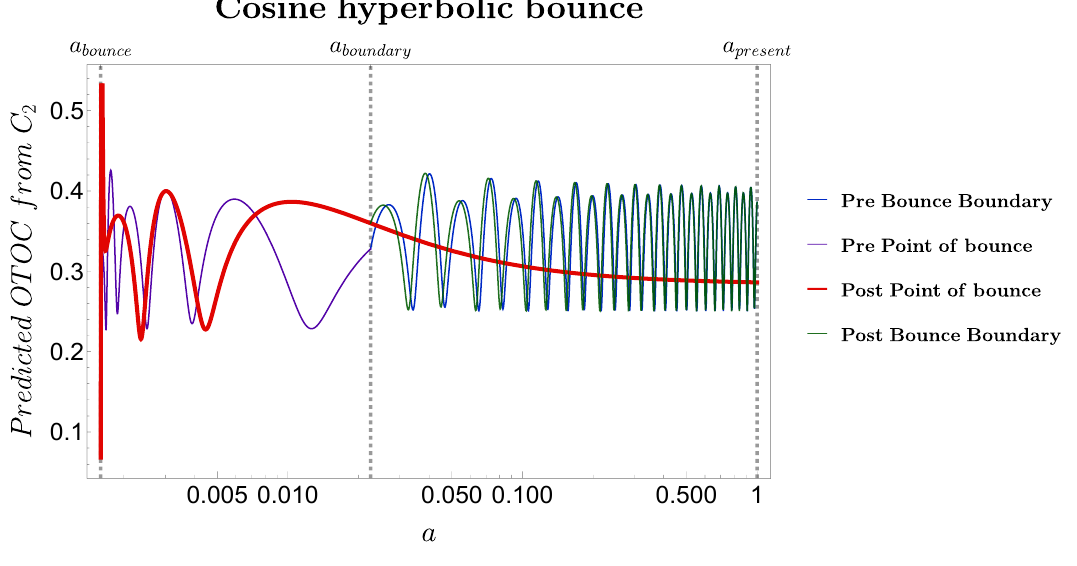
Figure 17: Predicted OTOC values from geodesically weighted Complexity at differ- ent regions against scale factor. Table 4: Predicted OTOC values at different points of interest with respect to scale